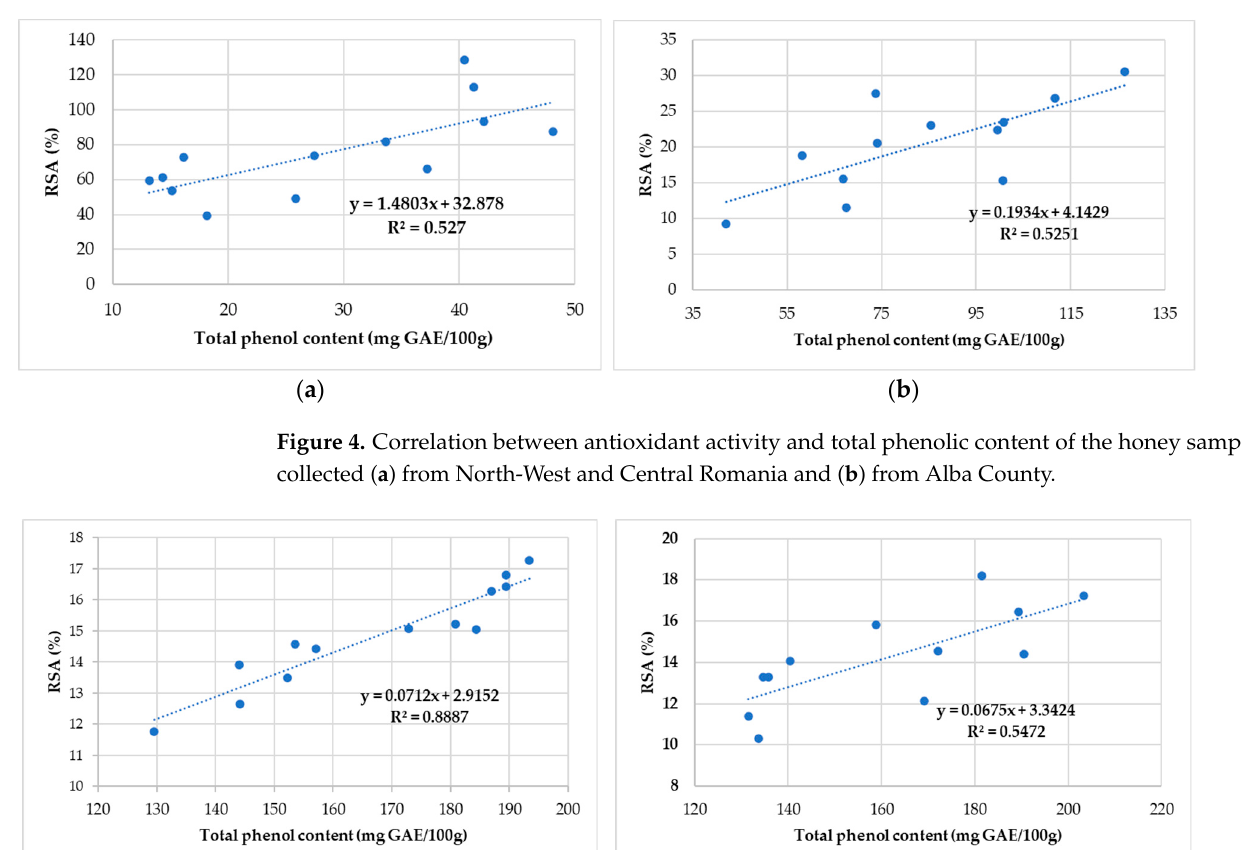
Figure 5. Correlation between antioxidant activity and total phenolic content for the propolis sample collected ( a ) from North-West and Central Romania and ( b ) from Alba County.